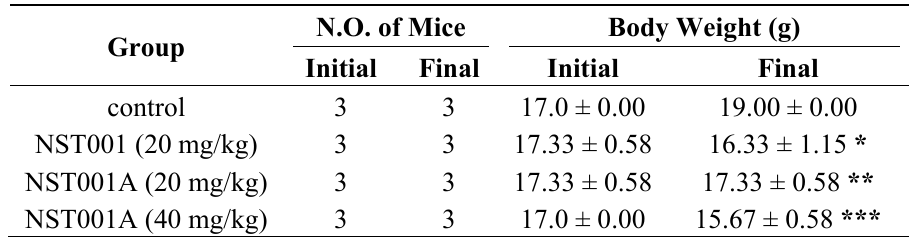
Table 4. The change of nude mice bodyweight of different drug loaded systems.